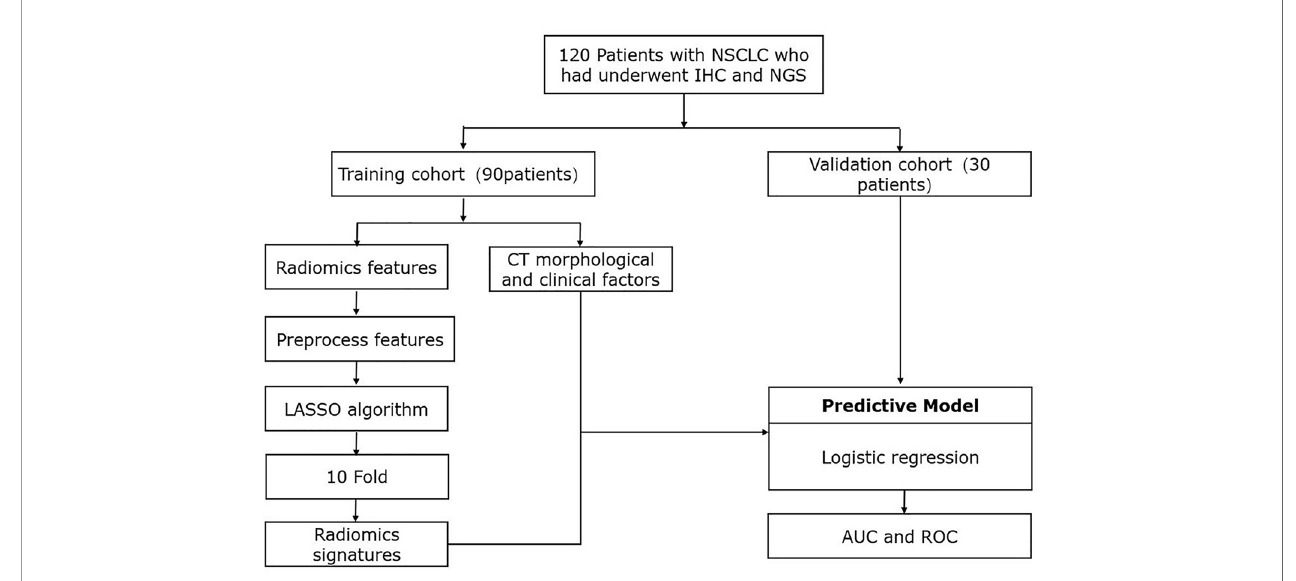
FIGURE 1 | Work fl ow of study design and radiomics process. IHC, immunohistochemistry, immunobiological staining; NGS, next-generation sequencing; CT, computed tomography; LASSO, least absolute shrinkage and selection operator; AUC, area under the curve; ROC, receiver operating